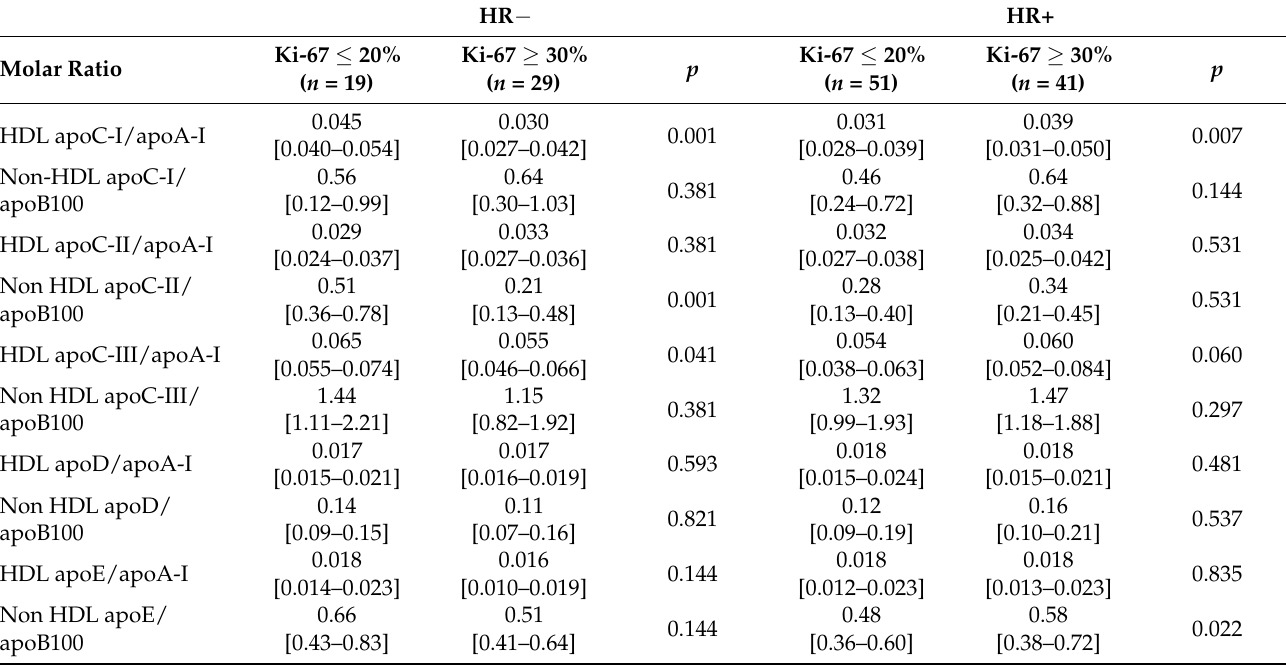
Table 4. Molar ratios between apolipoproteins and apoA-I in HDL or apoB100 in non-HDL. Data are presented with median (25th–75th